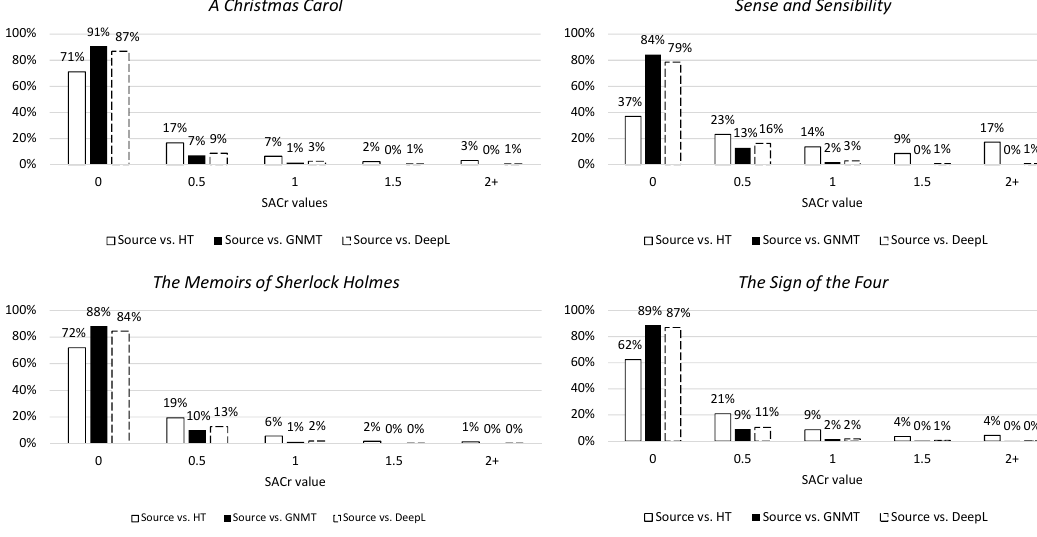
Figure 11. Distribution of SACr values in percentages per novel. The 0 column contains values [0:0.5[, the 0.5 column [0.5:1[, etc.